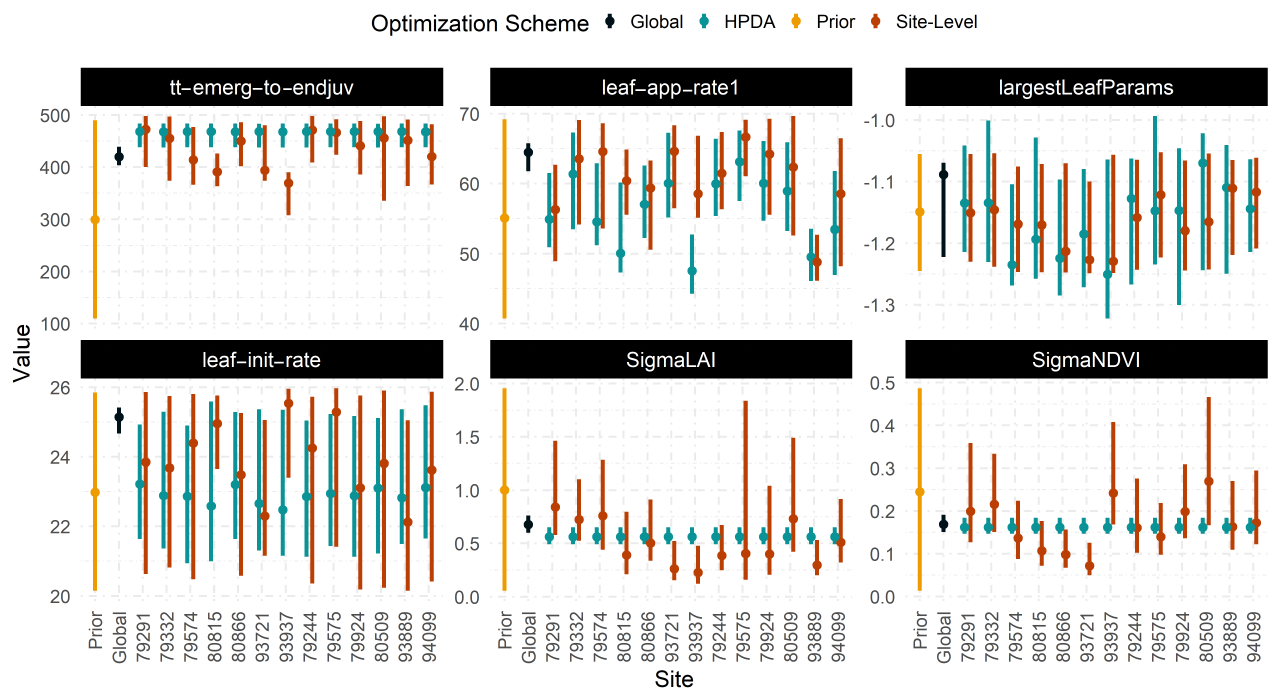
Figure 8. 95% Confidence interval for various crop model parameters across different optimization schemes and